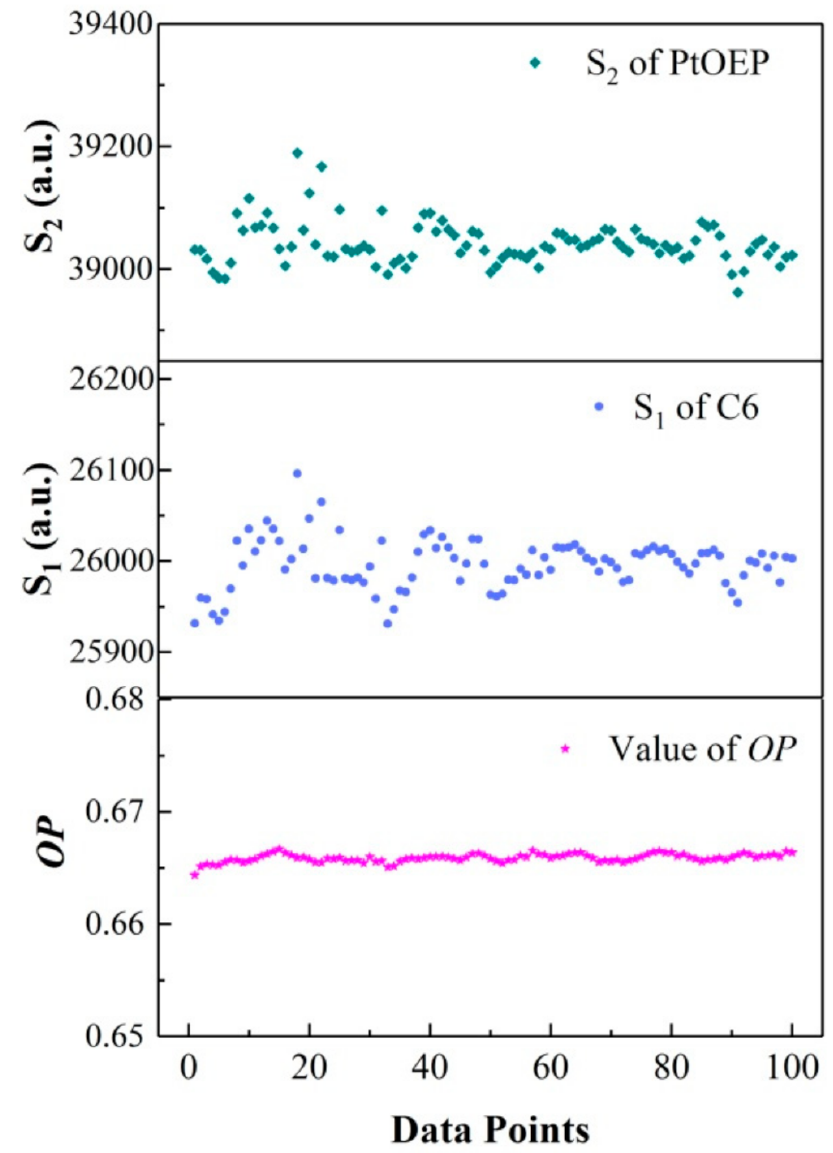
Figure 6. Variation in the values of OP , luminescence intensity of I PtOEP , and I C6